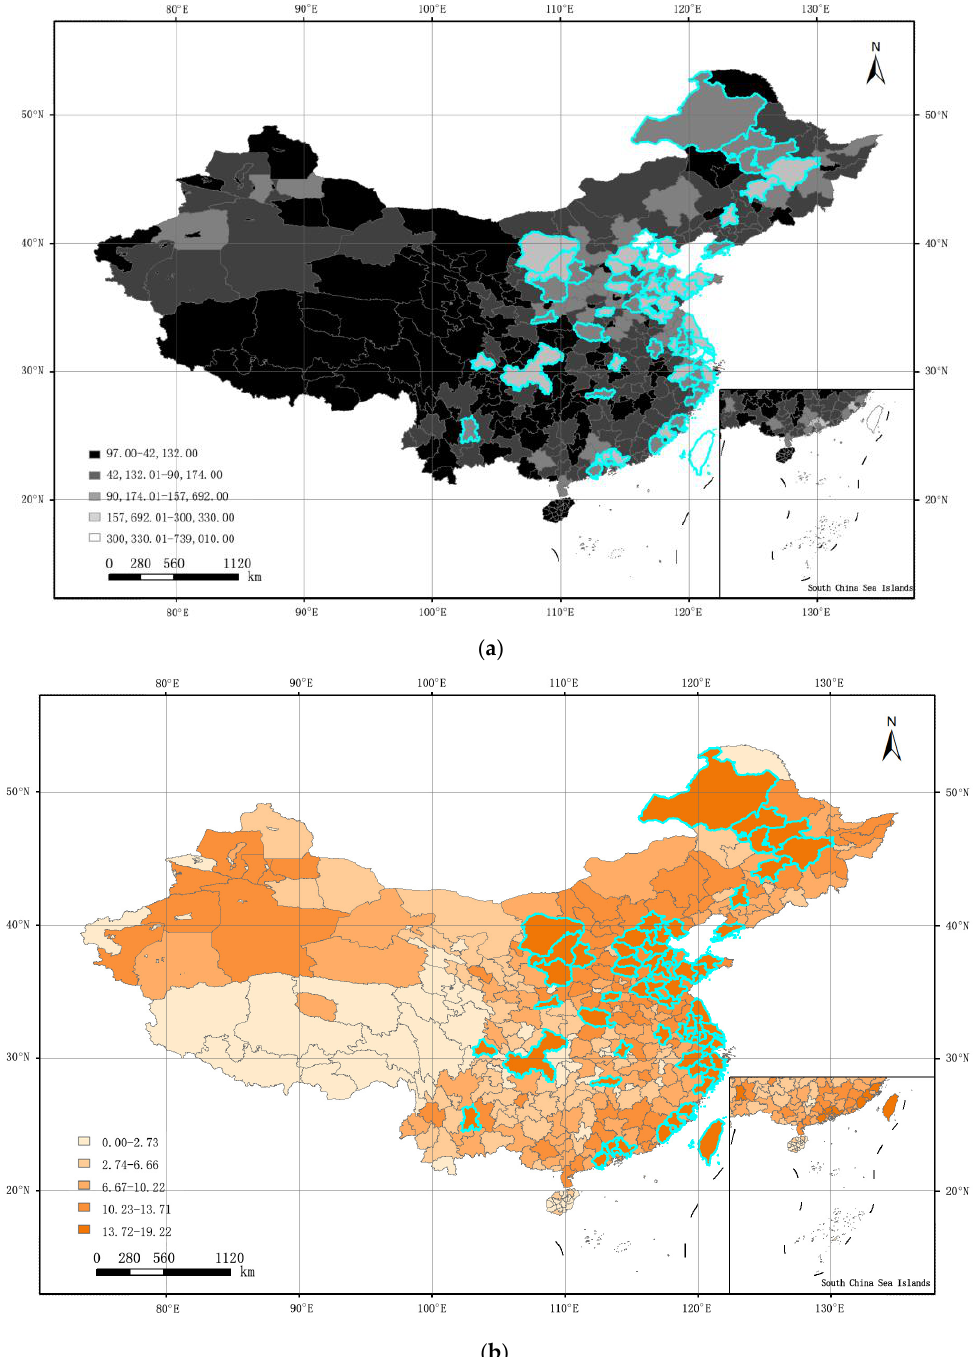
Figure 3. Municipal SUM of DN and municipal ODR in large and medium-sized cities in China. ( a ) Municipal SUM of DN in large and medium-sized cities; ( b ) Municipal ODR in large and medium- sized cities.